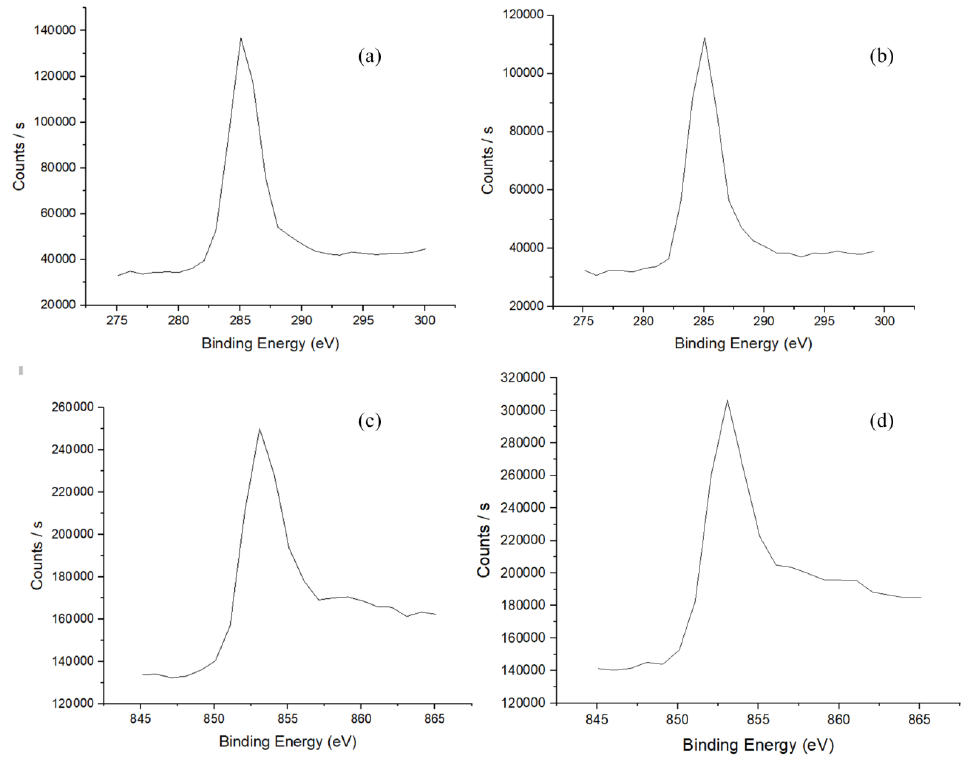
Figure 10. C1s and Ni 2p3/2 regions of high-resolution XPS spectra obtained with carbon and Ni in the Ni-graphene nanocomposite coating: ( a ) C1s on surface; ( b ) C1s on scratch; ( c ) Ni2P on surface; ( d ) Ni2P on scratch.